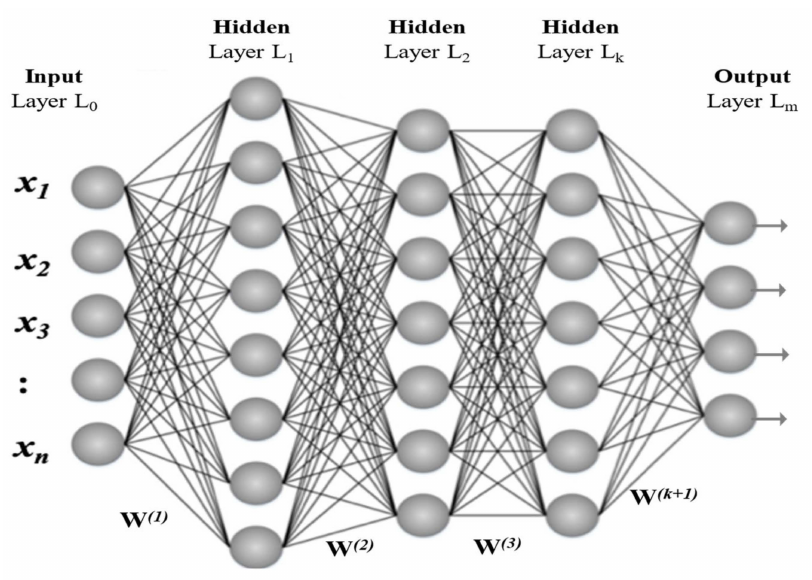
Figure 2. Visualization of Deep Leaning Model using Multilayer